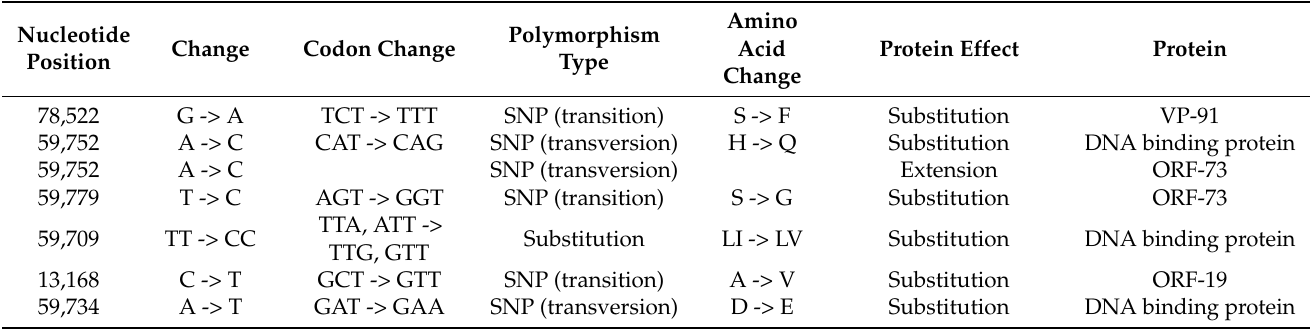
Table 4. Seven new SNPs identified in the CrleGV-SA C5